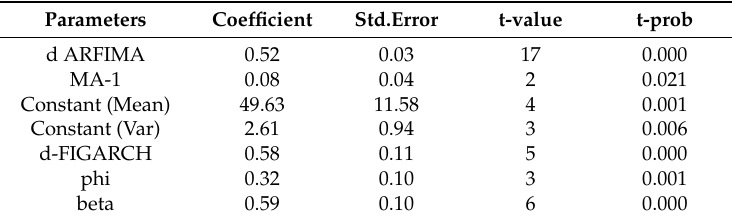
Table 1. Electricity futures prices (Phelix-DE, base 1–24 hours) estimated by Baillie-Bollerslev-Mikkelsen method [53], 2 December 2008 to 28 September 2018.